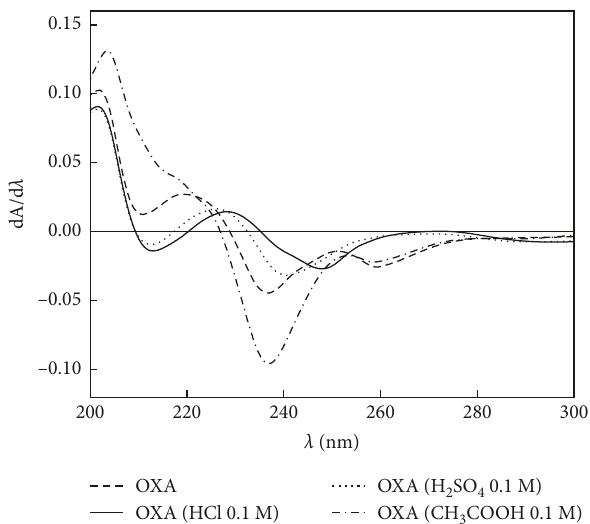
Figure 3: OXA first-order absorption derivative spectra after partial hydrolysis. [OXA]